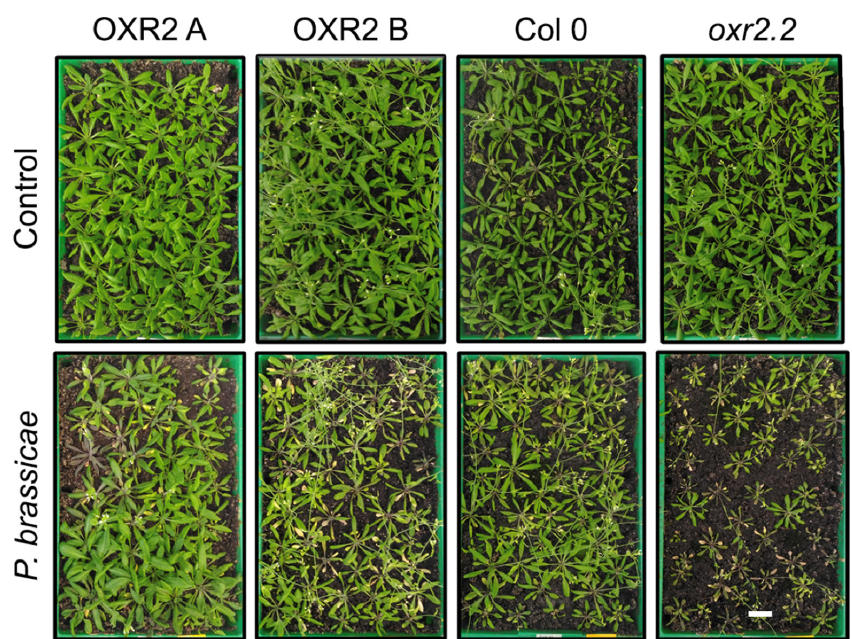
Figure 2. Upper plant parts of representative trays after inoculation of Col-0, oxr2 and two independent OXR2-OE lines (A and B) with 10 6 spores mL − 1 of P. brassicae (see also Figure 3C, shoot index). The control plants were only inoculated with the buffer that had been used to resuspend the resting spores. The photos were taken 28 dai. The bar is the same size for all panels and represents 2 cm.